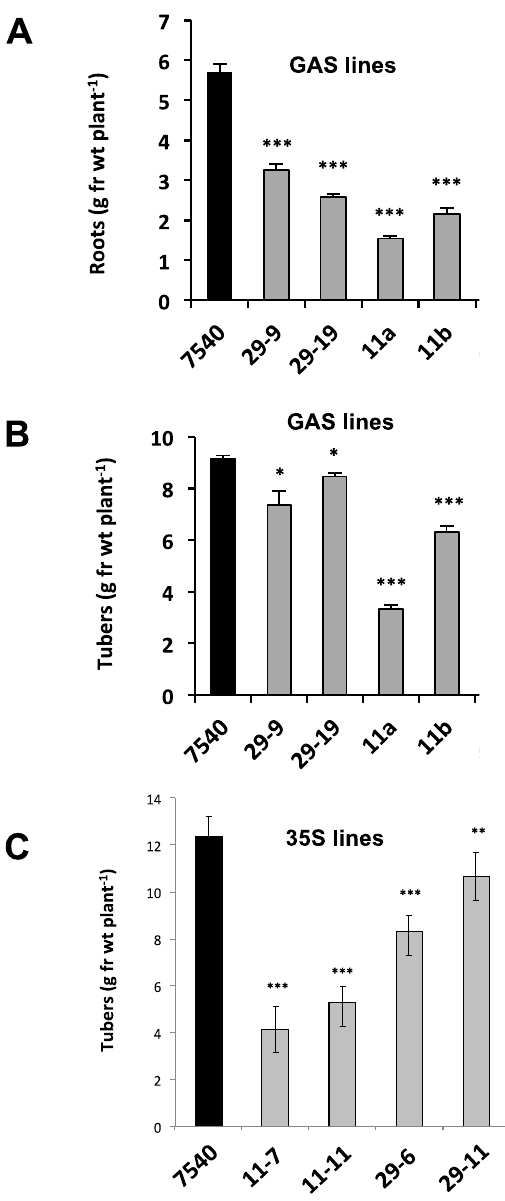
Figure 5. Root ( A ) and tuber ( B ) yields from non-transformed S. tuberosum ssp. andigena (WT line 7540) and GAS::StBEL11 and -29 transgenic lines grown under short-day conditions in growth chambers. ( C ) Tuber yields in 7540 (WT), 35S::StBEL11 (lines 7 and 11) and 35S::StBEL29 (lines 6 and 11) transgenic lines. Plants were grown under long days for four weeks followed by three (GAS lines) or four (35S lines) weeks under short-day conditions. At harvest, shoots were weighed, and tubers and roots were washed in water, blotted dry and weighed. Data (g·fr·wt plant − 1 = grams fresh weight per plant) represent the mean of four (GAS lines) or seven (35S lines) biological replicates. Error bars represent ±SD. One, two or three asterisks indicate significance ( p < 0.05, p < 0.01 and p < 0.001, respectively) using a Student’s t- test. By permission of the publisher [10].